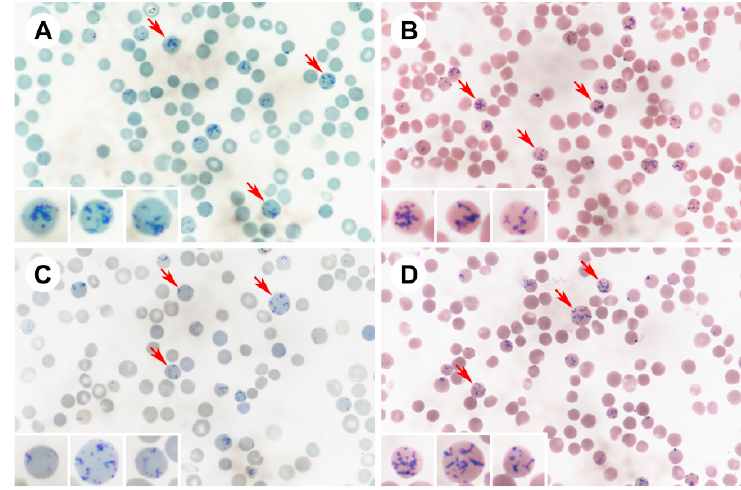
Figure 2. Blood smears processed with ( A ) brilliant cresyl blue (BCB), ( B ) BCB and Liu’s stain, ( C ) new methylene blue (NMB), and ( D ) NMB with Liu’s stain being microscopically examined with 1000× immersion objective lenses. Representative reticulocytes labeled with arrows. Note the characteristic blue reticular staining pattern of ribonucleic acid residues (lower-left corners).